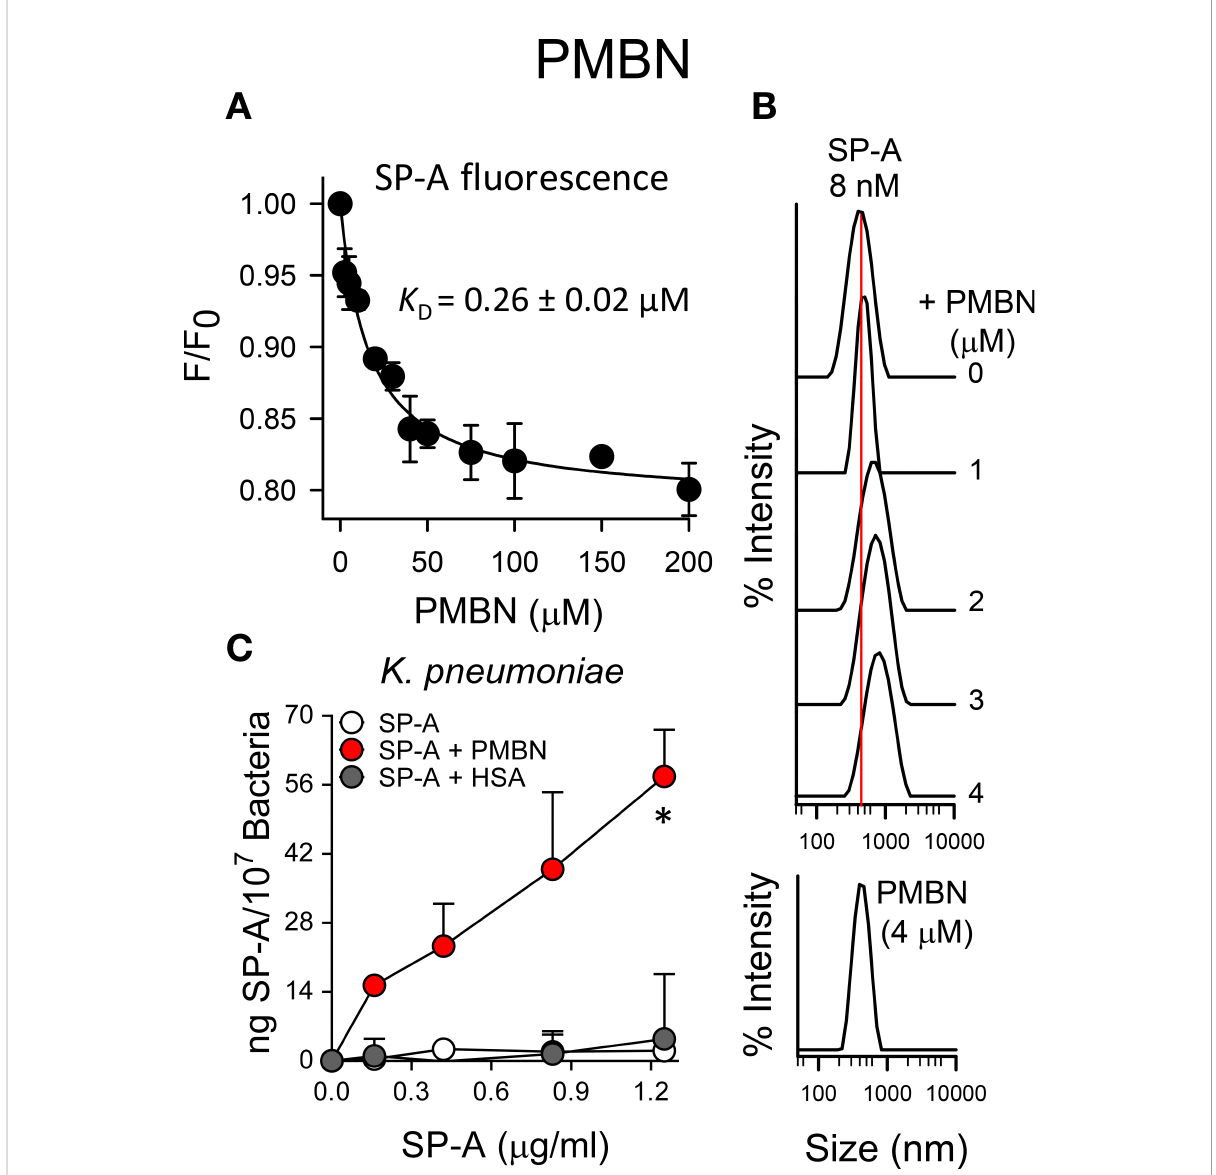
FIGURE 7 SP-A and PMBN interact in a dose-dependent manner, forming molecular aggregates that allow binding of SP-A to K pneumoniae . (A) Binding of SP-A and PMBN was examined by changes in intrinsic fl uorescence emission spectra of SP-A (15 nM; 10 m g/ml)) by addition of increasing concentrations of PMBN (0 to 200 µM; 0-192 m g/ml)) at 25°C in 5 mM Tris-HCl buffer (pH 7.4) containing 150 mM NaCl. Results are expressed as F/F 0 , where F and F 0 are the corrected emission intensities at 337 nm in the presence and absence of PMBN. Results are means ± SD of four experiments. (B) DLS analysis of the hydrodynamic diameter of SP-A/PMBN complexes in 5 mM Tris-HCl, 150 mM NaCl buffer (pH 7.4). The y- axis represents the relative intensity of the scattered light; the x-axis denotes the hydrodynamic diameter of the particles present in the solution. DLS analyses of SP-A and PMBN particles alone are also shown. One representative experiment of four is shown. (C) Binding capacity of biotinylated SP-A to K pneumoniae (10 7 CFU) in the presence and absence of PMBN (5 m g/ml) or HSA (5 m g/ml). The concentration of biotinylated SP-A associated with K pneumoniae was measured by a solid phase binding assay and expressed as total nanograms of SP-A/10 7 bacteria. The results are the mean ± SD of three independent experiments with three biological replicates. A value of * p < 0.05 was obtained for the one-way